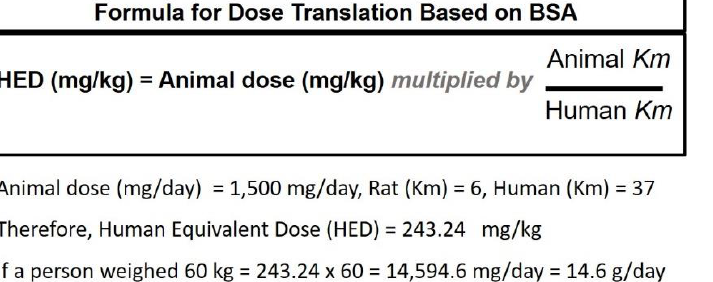
Figure 1. The formula for dose translation based on body surface area (BSA), modified from Reagan- Shaw et al., 2008 [3].